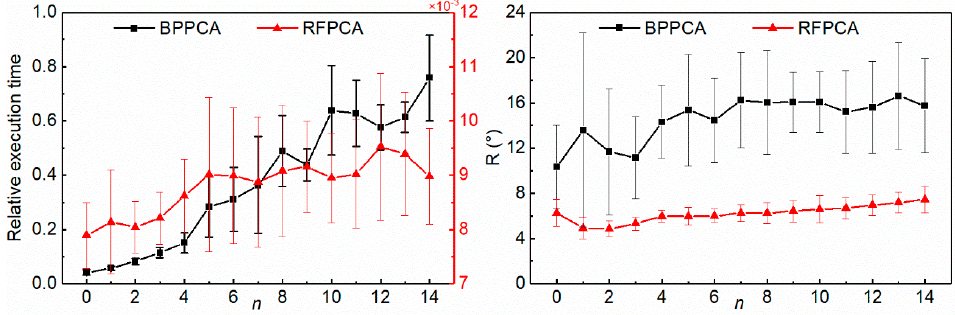
Figure 8. The relative execution time and R for the estimation with different previous input.